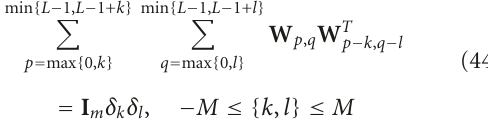
the performance